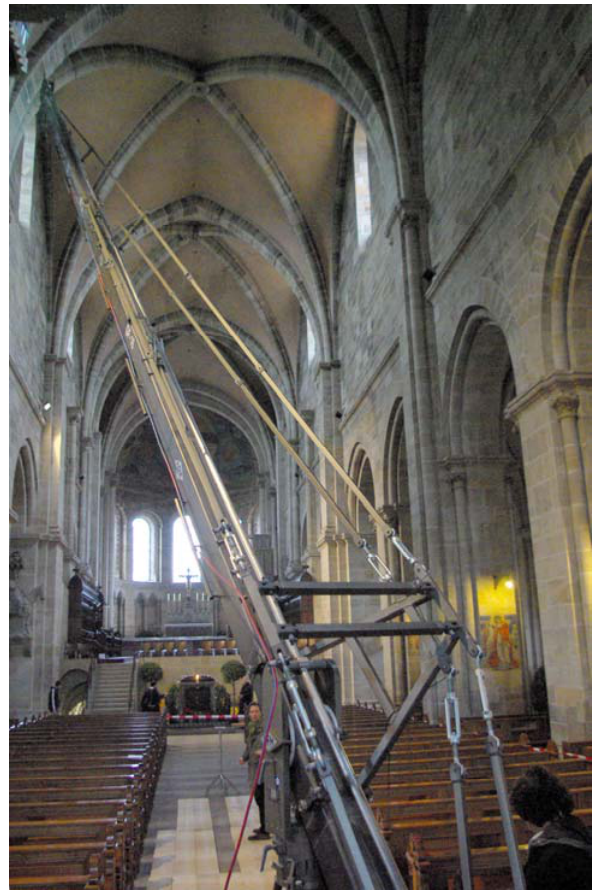
Picture 11. GF16 in the cathedral of Bamberg ©by S.Siebe 2.4.3